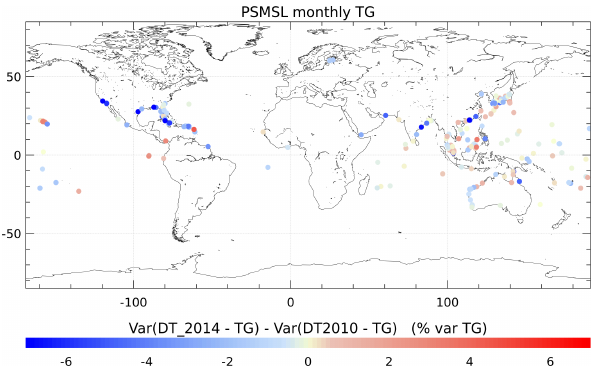
Figure 14. Difference of the variance of the altimeter SLA minus TG SLA differences, using successively DT2014 and DT2010 SLA gridded products. Monthly TG from PSMSL. Negative values mean that the SLA differences between altimetry and TGs are reduced when considering DT2014 products.